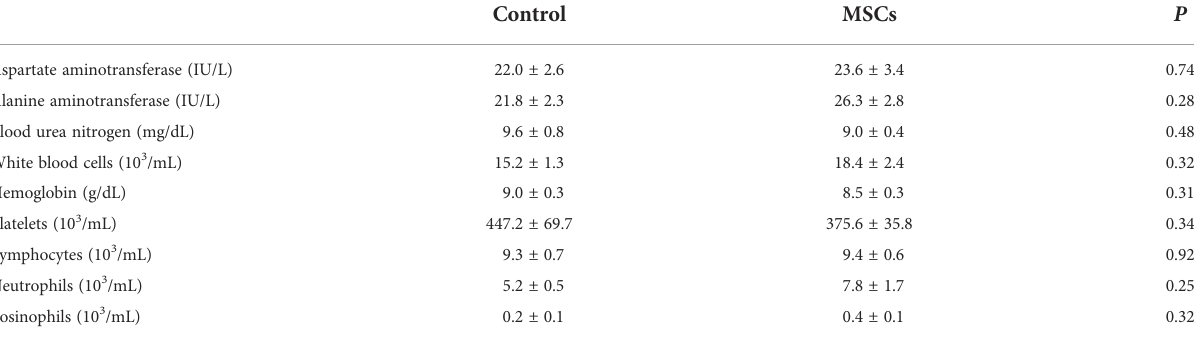
TABLE 1 Biochemical blood pro fi le of Control and MSCs groups of pigs two weeks after